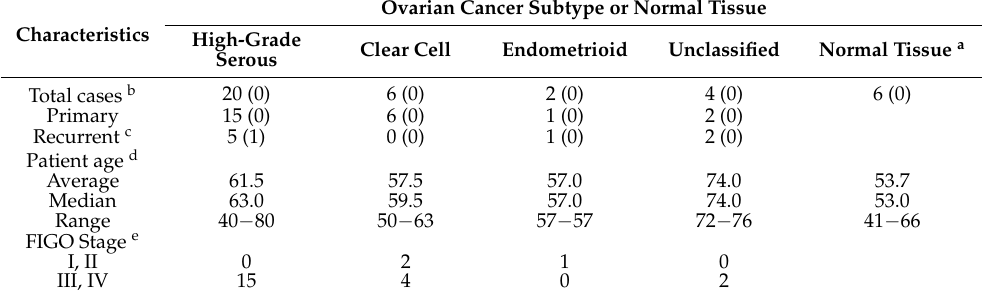
Table 1. Clinicopathological characteristics of 32 ovarian cancer tissues from 24 patients and 6 normal